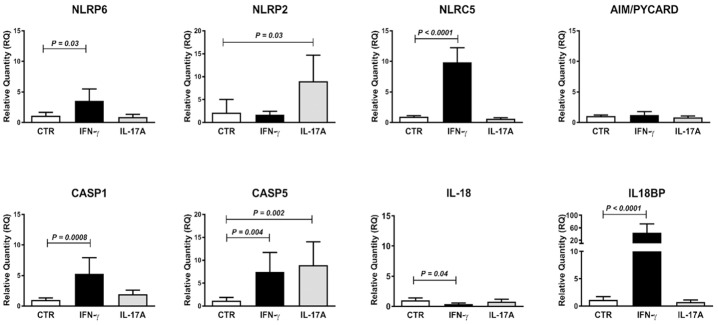
Expression levels of mRNAs for the inflammasome pattern recognition receptor molecules and caspase activators NLRP6 and NLRC5 as well as two the caspases, CASP1 and CASP5, are all increased by IFN-γ while IL-17A causes increase in expression levels of NLRP2 and CASP5 mRNAs.Expression levels of NLRP6, NLRP2, NLRC5, AIM/PYCARD, CASP1, CASP5, IL-18 and IL-18BP mRNAs in short-term enteroid cultures developed from duodenal biopsies of one clinical control and incubated for 24 h with IFN-γ or IL-17A added to the medium, i.e. at the basolateral side, or sham-treated (CTR) with 4 enteroid cultures per group. For methods and statistics used see legends to Figs 1 and 2 and Material and methods.